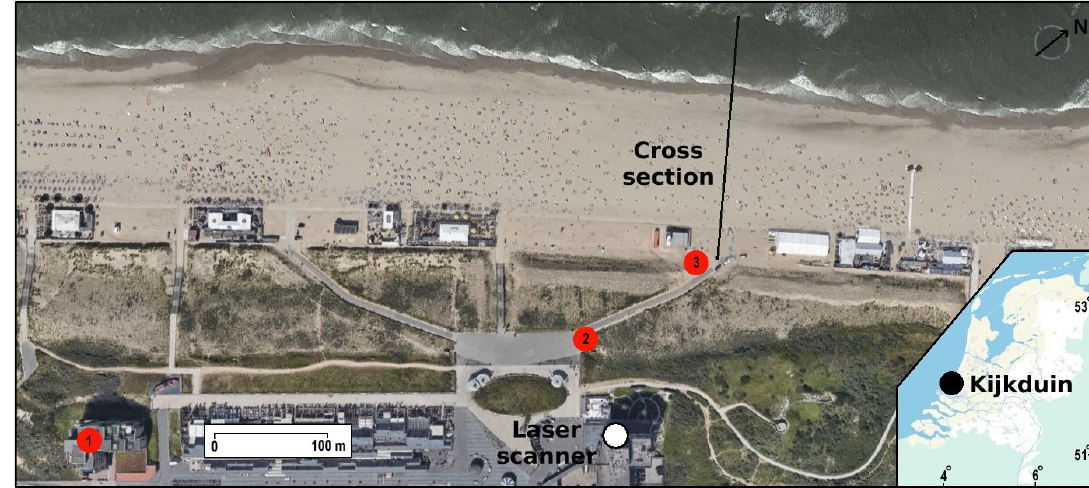
Figure 2 . Overview of the Kijkduin study area with the laser scanner and cross-section used in the analysis. Red points (numbered 1–3) indicate the reference object locations used for georeferencing (see Section 2.2).